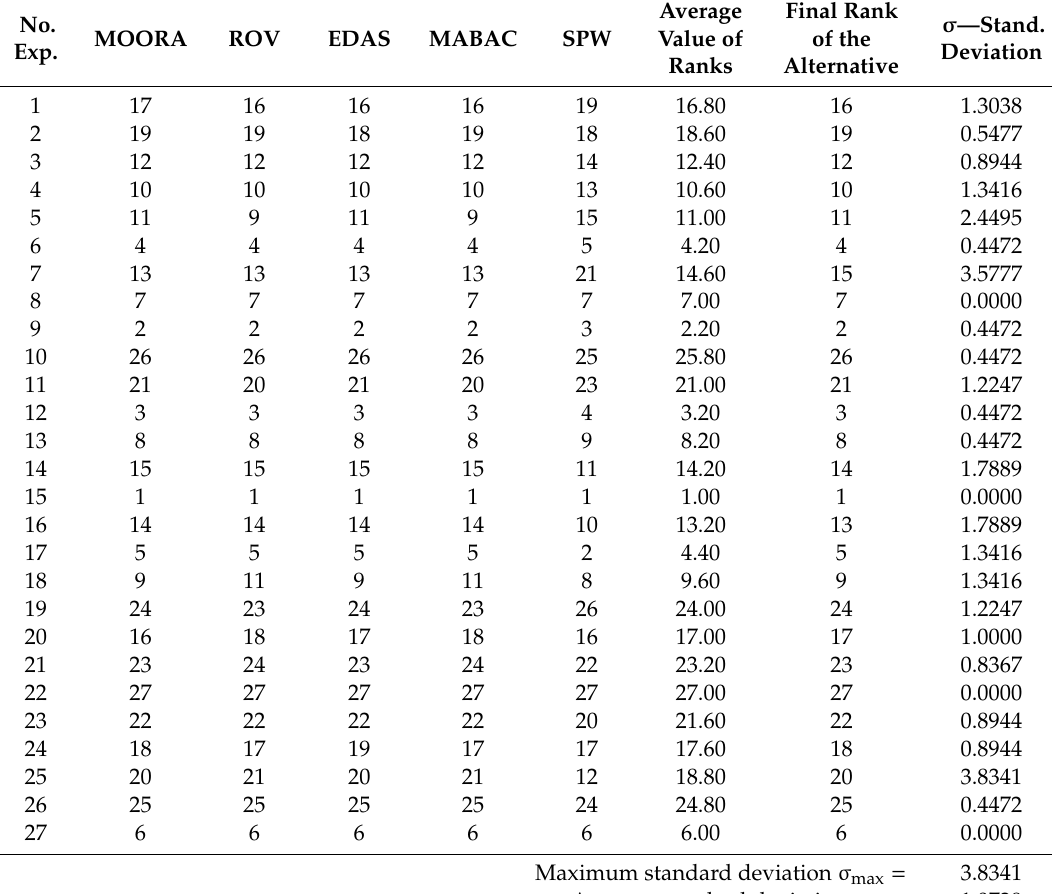
Table 9. Results of comparing the ranks of the alternative parameter levels—the second iteration. No. Exp.